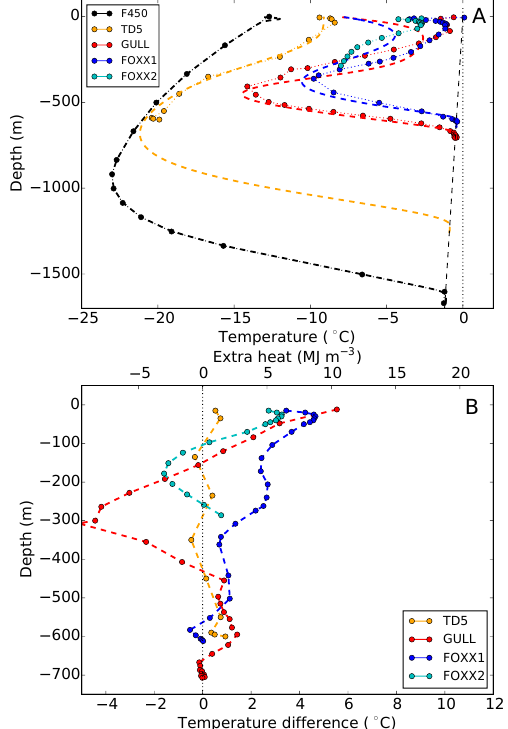
Figure 7. Same as Fig. 5 but for model run mCEF (crevasses, en- hanced shear straining, and temperate